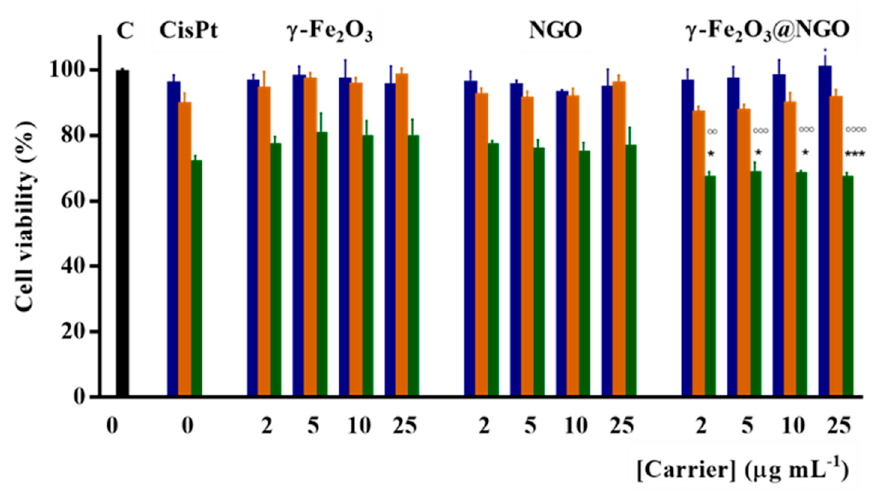
Figure 8. U87 viability after 72 h incubation with CisPt concentrations 2.5 ( blue ); 5.0 ( orange ); and 10.0 ( green ) µM in the free form and after loading on γ -Fe 2 O 3 ; NGO; γ -Fe 2 O 3 @NGO. Carrier